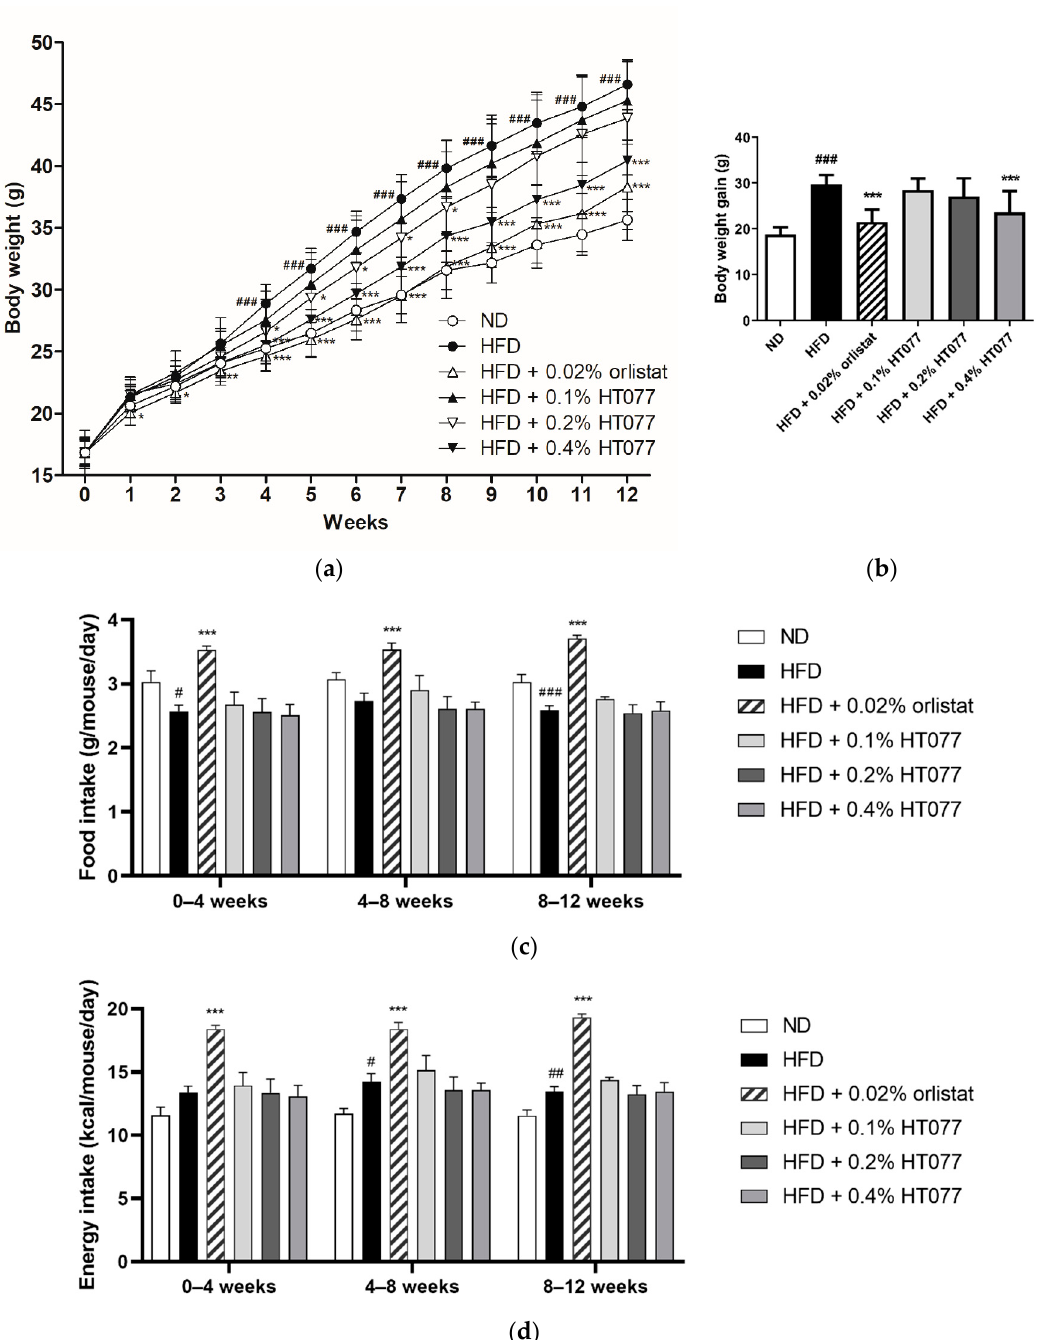
Figure 1. Effects of an extract mixture of Prunus persica and Nelumbo nucifera (HT077) on body weight, and food and energy consumption in C57BL/6 mice fed a high-fat diet (HFD). ( a ) Body weight changes in mice that received either a normal diet (ND), HFD, HFD containing 0.02% orlistat, or HFD containing 0.1, 0.2, or 0.4% HT077 for 12 weeks. ( b ) Body weight gain for 12 weeks. Changes in ( c ) food intake and ( d ) energy intake over 12 weeks. All values are presented as the mean ± SD ( n = 8 for ND, 16 for HFD, and 12 for the other groups). # p < 0.05, ## p < 0.01, and ### p < 0.001 vs. ND group; * p < 0.05, ** p < 0.01, and *** p < 0.001 vs. HFD control group.